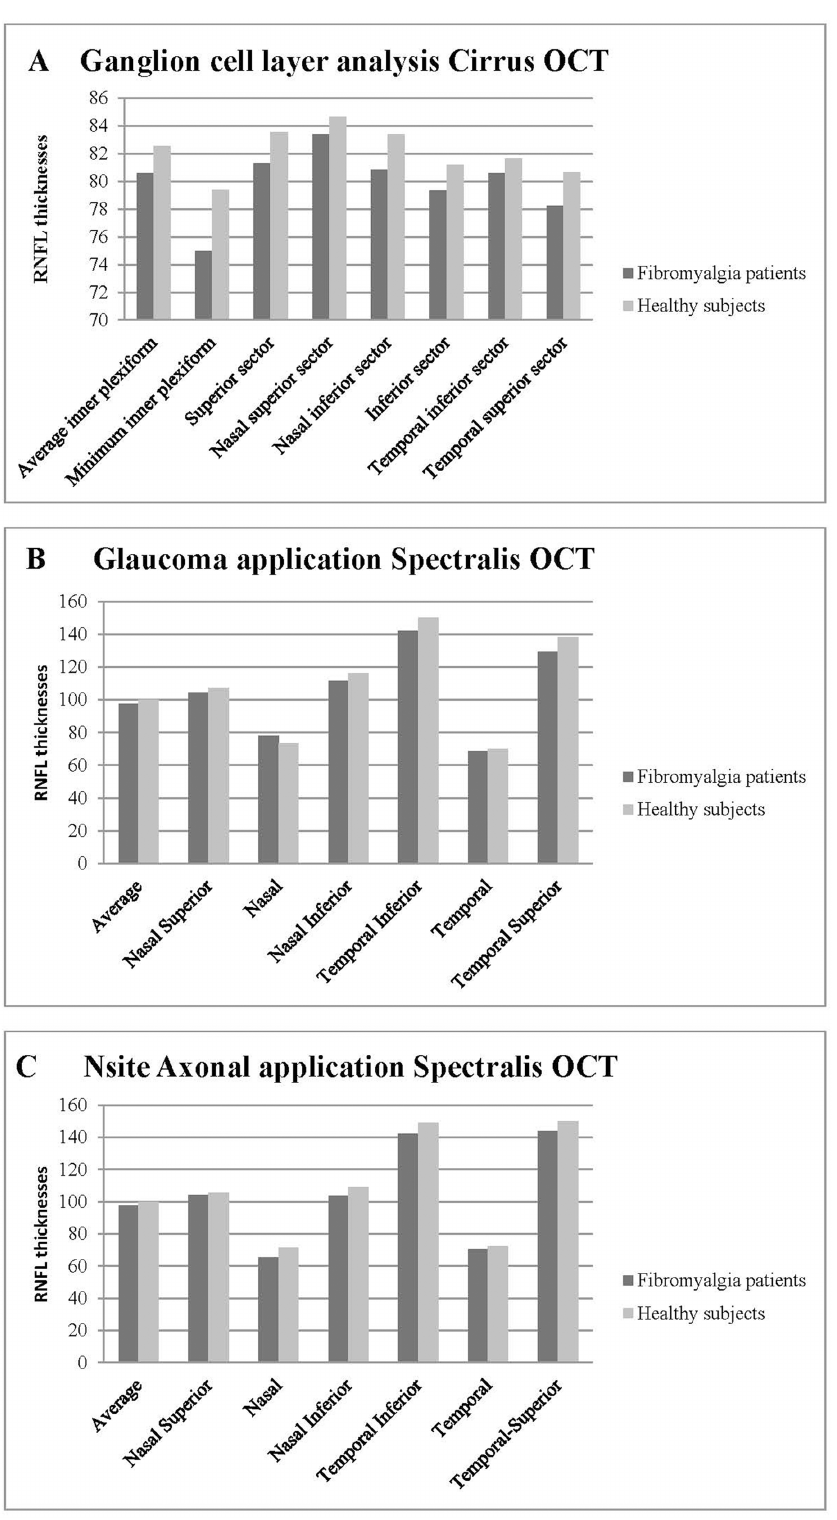
Fig 2. Bar charts representing optical coherence tomography (OCT) measurements in eyes from 116 fibromyalgia patients and 144 controls. A- Retinal nerve fiber layer measurements using the ganglion cell layer analysis of Cirrus OCT device. B- Retinal nerve fiber layer measurements using the Glaucoma analytic